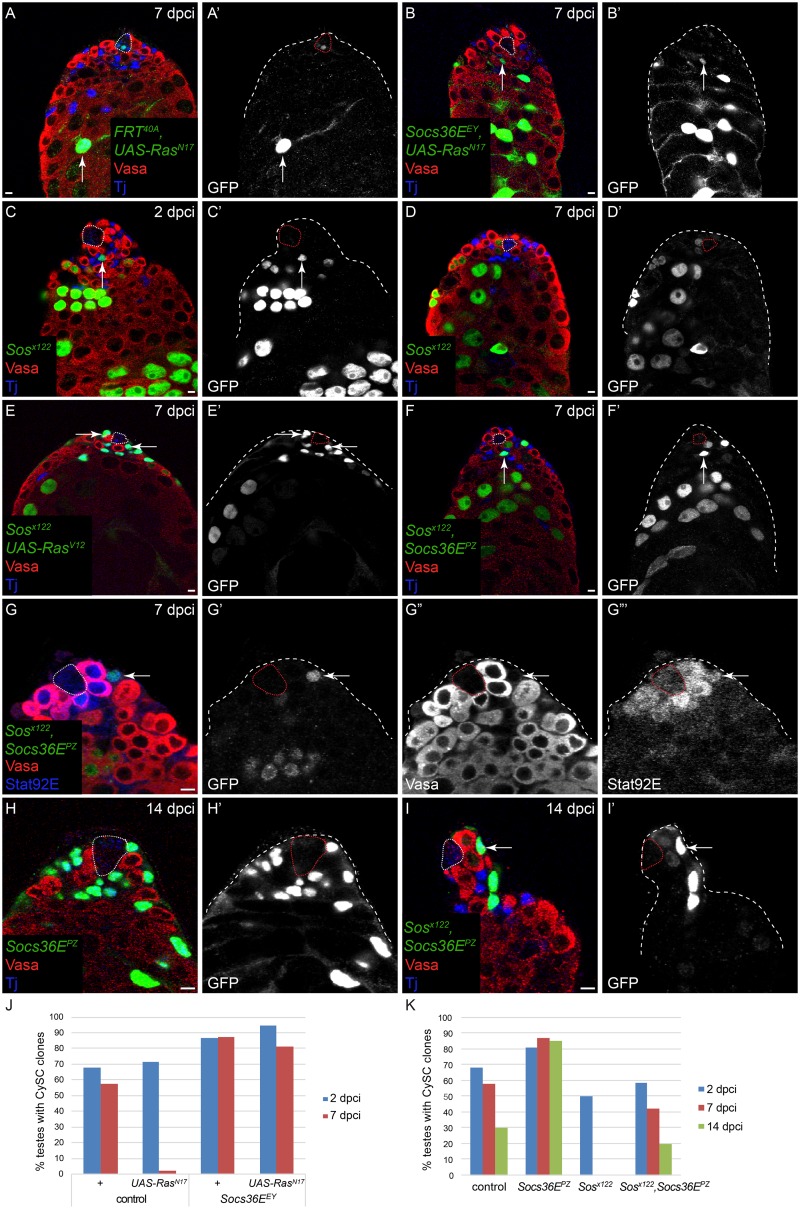
Socs36E regulates CySC competition via MAPK.All clones were generated by the MARCM technique and are positively-marked by the expression of GFP. A) UAS-RasN17 CySC clones are not recovered at 7 dpci but their differentiating offspring are observed (arrow). B) By contrast, Socs36E, UAS-RasN17 CySCs are readily recovered at 7 dpci (arrow). C, D) A Sos mutant CySC is recovered at 2 dpci (C, arrow) but not 7 dpci (D). E) Sos mutant CySCs are rescued when an activated form of Ras (RasV12), which functions downstream of Sos, is also expressed in the clones (E,E’, arrows). F) Sos, Socs36E double mutant CySCs are also recovered at 7 dpci (arrow). G) Sos, Socs36E double mutant clones have robust staining for Stat92E (arrow). H) Socs36E mutant clones have colonized the niche at 14 dpci. I) Sos, Socs36E double mutant CySC clones are recovered at 14 dpci (arrow), indicating clone persistence. However, unlike Socs36E single mutant clones, Sos, Socs36E double mutant clones do not colonize the niche, indicating that MAPK signaling regulates the competitiveness of Socs36E mutant clones. J,K) Graphs showing CySC clone recovery rates at 2 (blue bars), 7 (red bars) and 14 (green bars in K) dpci. Whereas CySCs expressing a dominant-negative Ras (UAS-RasN17) are not recovered at 7 dpci, Socs36E, UAS-RasN17 CySCs are robustly recovered (J). In K, control CySC clones have reduced recovery rates over time, consistent with stochastic loss and replacement [18]. By contrast, Socs36E mutant CySCs are not lost over time, indicating their competitive advantage. While Sos single mutant clones are not recovered at 7 and 14 dpci, Sos, Socs36E double mutant clones are readily recovered and in a similar fashion to control clones. Vasa is red in all panels. Tj is blue in A-F, H,I. Stat92E is blue in G. The hub is outlined by a dotted line. Scale bar = 5 μM.